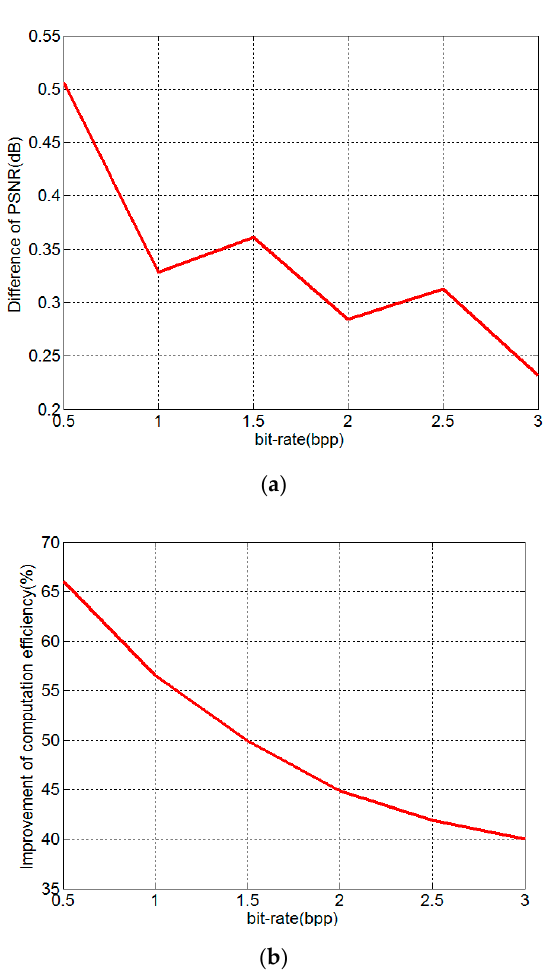
Figure 10. Comparison of compression performance and compression time: ( a ) decreased PSNR of proposed method compared to conventional NTD; and ( b ) the improvement of the proposed method compared to conventional NTD. Table 5. Comparison of the computation efficiency and compression performance.